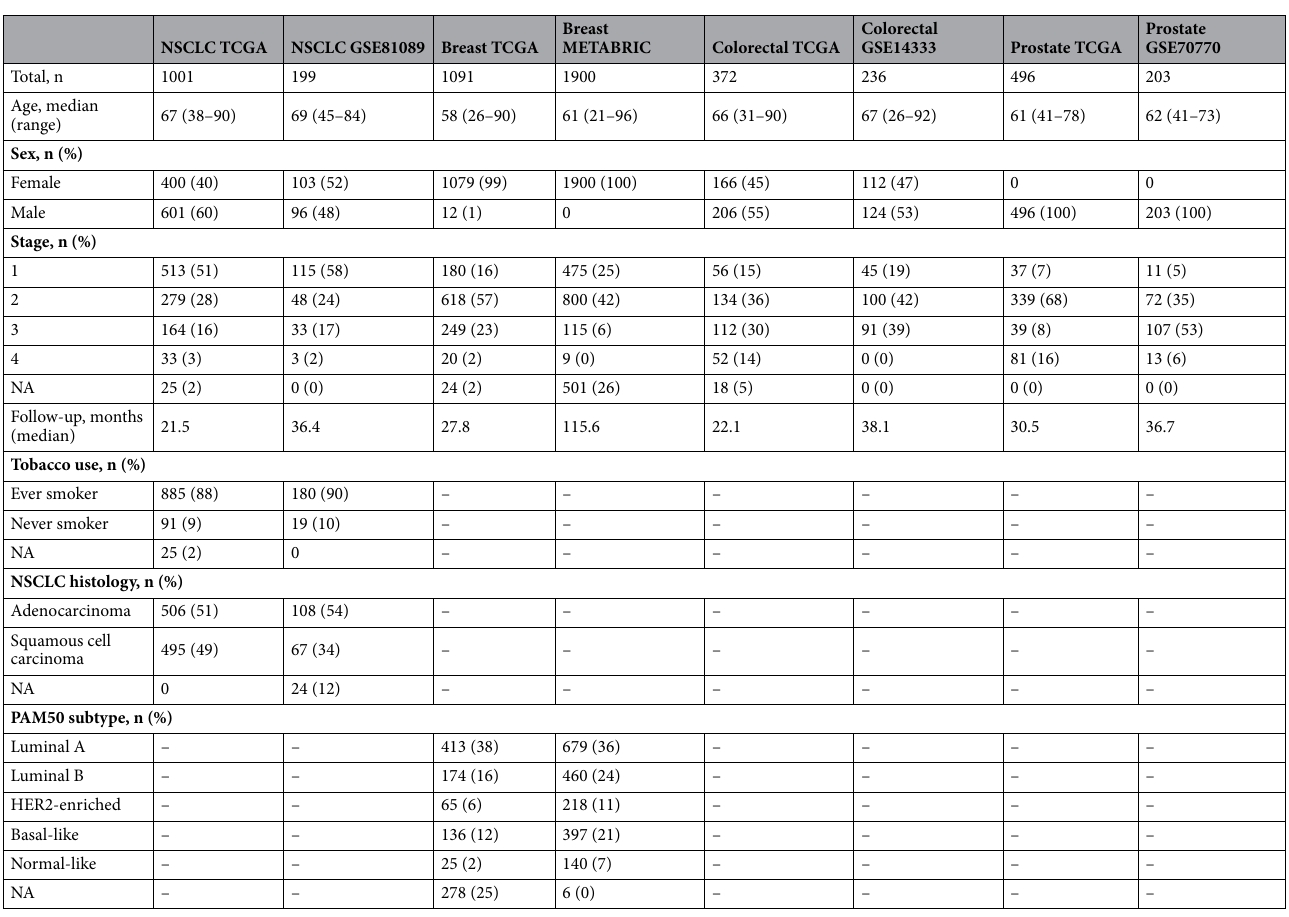
Table 1. Demographics and clinical parameters of the cohorts evaluated in the outcome